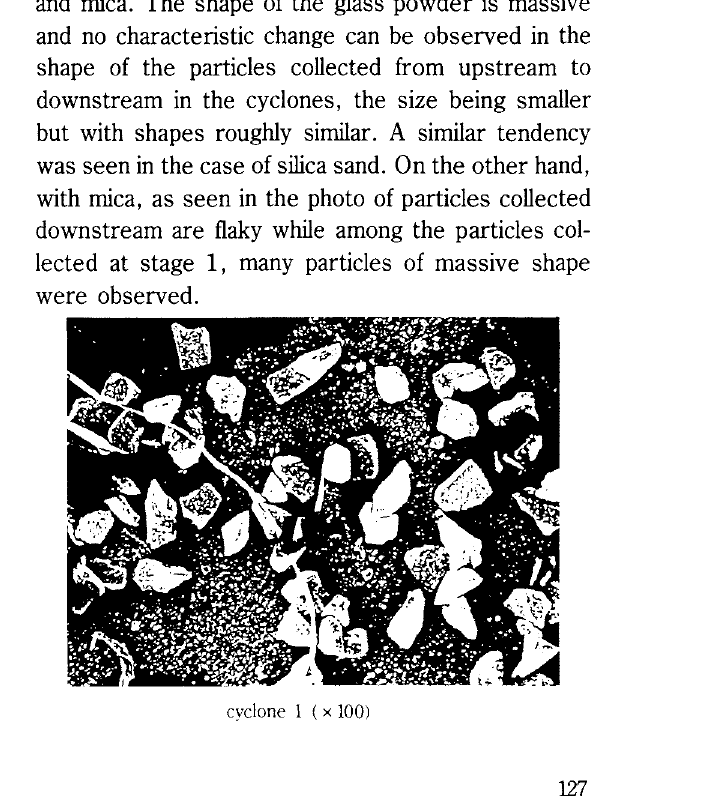
Fig. 6 Relation between cutoff diameters of the cyclones and the 50% diameters of particles classified by them Figs 7 and 8 show SEM photos of glass powder and mica. The shape of the glass powder is massive and no characteristic change can be observed in the shape of the particles collected from upstream to but with shapes roughly similar. A similar